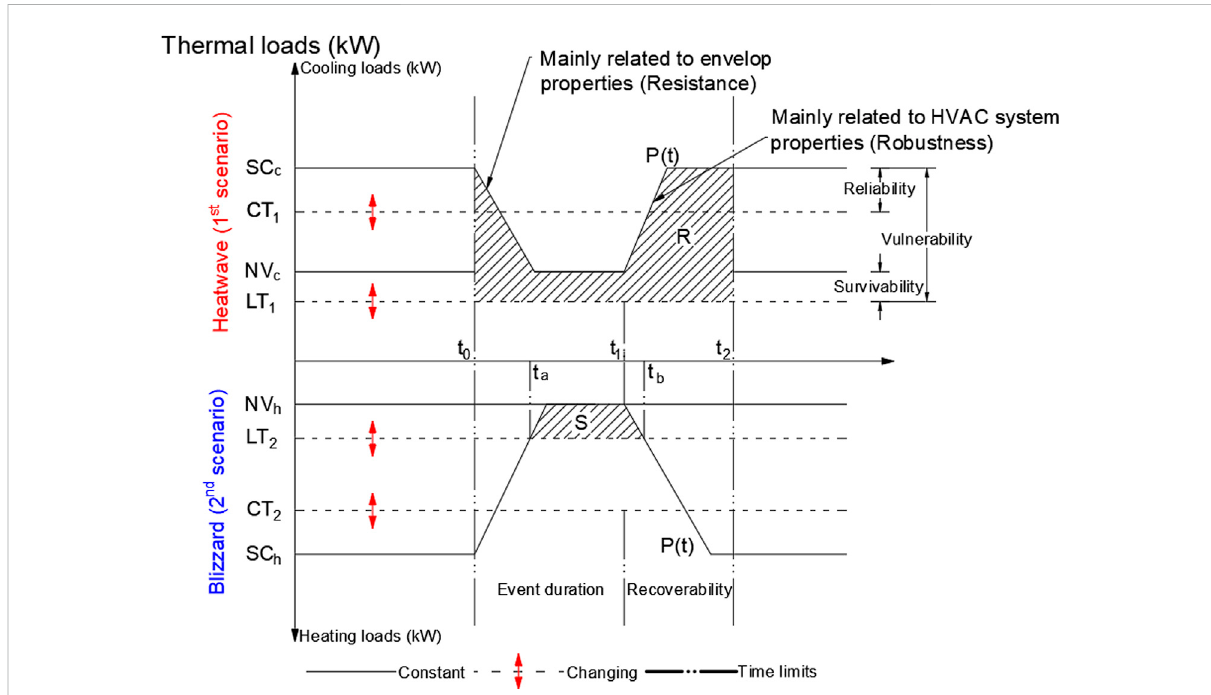
FIGURE 2 Building Thermal Resilience Pro fi le (BTRP). The suggested BTRP covers both ends of thermal load (heating and cooling) and includes certain limits:SystemCapacity(SC);ComfortThreshold(CT);NaturalVentilationcapacity(NV);Life-safetyThreshold(LT);t 0 ,t 1 ,andt 2 are:themomentevent starts, the moment event ends, and the maximum allowed recovery duration, respectively; t a and t b are: the moment when the system loses the capacitytomeetLTloads,andthemomentthesystemregainscapacity,respectively;c&hsubscriptionsrefertocoolingandheatingcapacities, respectively. This fi gure shows two scenarios, the fi rst one happens during a heatwave where the natural ventilation capacity (NV) still allows the systemtoovercomeLTdemands;thus,wecanevaluatethesystemresilience(R).Thesecondscenarioisduringcoldweather,wherethesystemfails to meet LT demands, and leads to calculating the situation severity index (S). In addition, some of the resilience qualities are presented in relation to these limits. CT & LT are continuously changing, re fl ecting the occupancy rates and thermal demands, while SC & NV are calibrated and modi fi ed only after regular